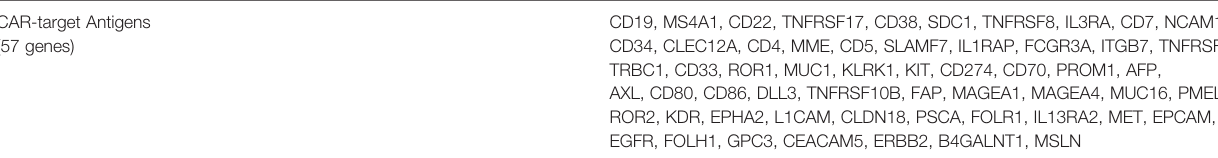
TABLE 1 | Common CAR-target antigens (57